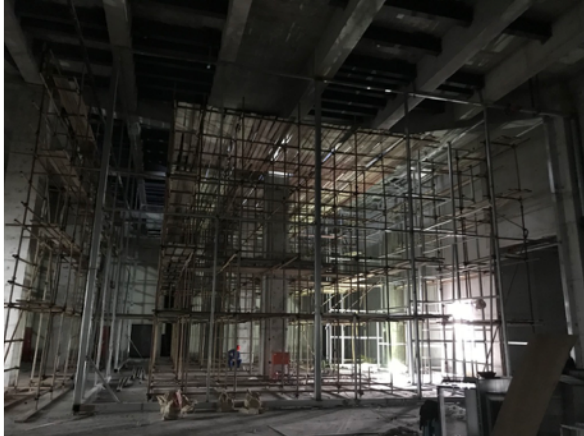
Figure 6. The support structures of the replica Cave 3 of the Yungang Grottoes, located in Qingdao City, China